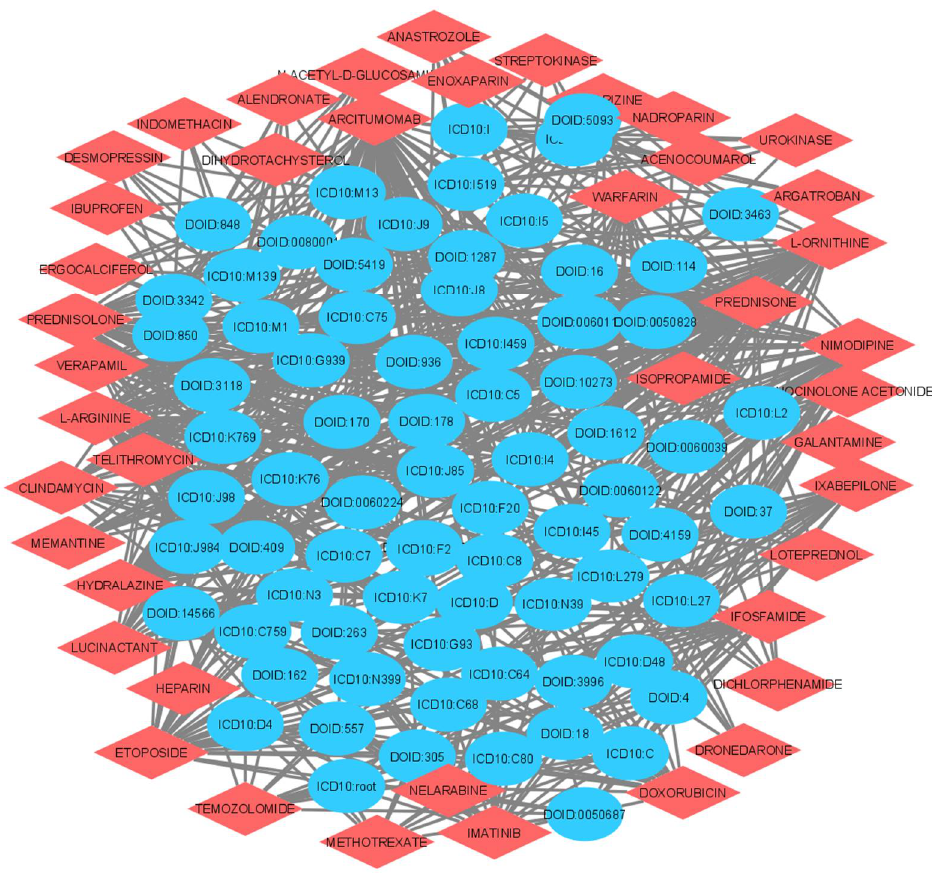
Figure 5. Disease Drug Network (Red nodes—Drugs, Blue nodes—Diseases).